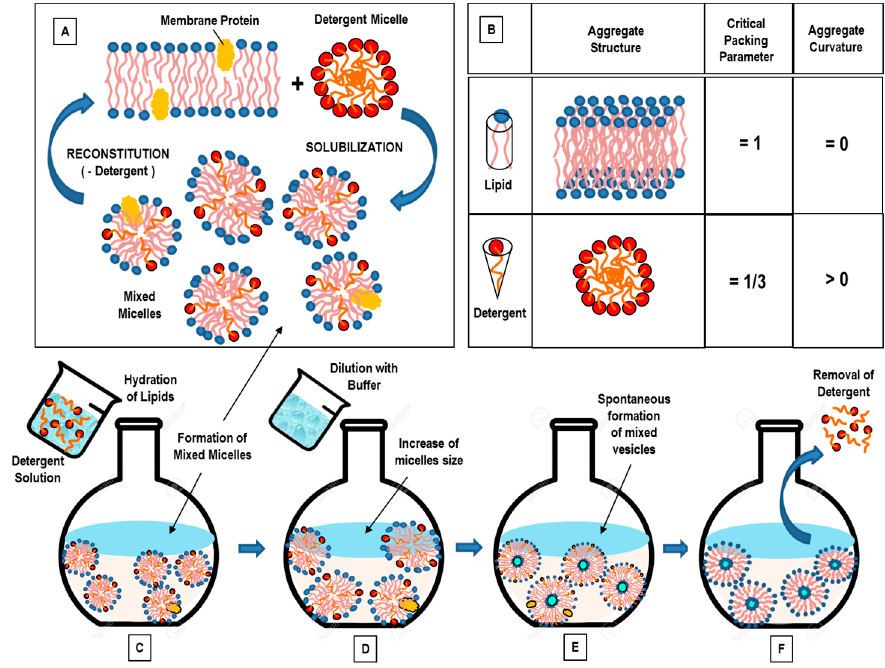
Figure 4 . Self-assembly process in mixtures of lipids and detergents. ( A ) Membrane solubilization and reconstitution by addition (or removal) of detergents. ( B ) Characteristic molecular geometries’ and aggregates’ structures of (pure) lipids and detergents. ( C – F ) Main stages of the detergent removal method. Initially, the lipid hydration with a detergent solution allows for the formation of mixed (detergent/lipids) micelles ( C ). The successive dilution of mixed micellar solution with aqueous buffer favors an increase of the mixed micelles’ size (and polydispersity) ( D ), followed by a transition to the vesicles’ structures ( E ). The formation process is completed by a complementary method for the removal of the residual detergent inside the liposomal nanoformulation ( F ).